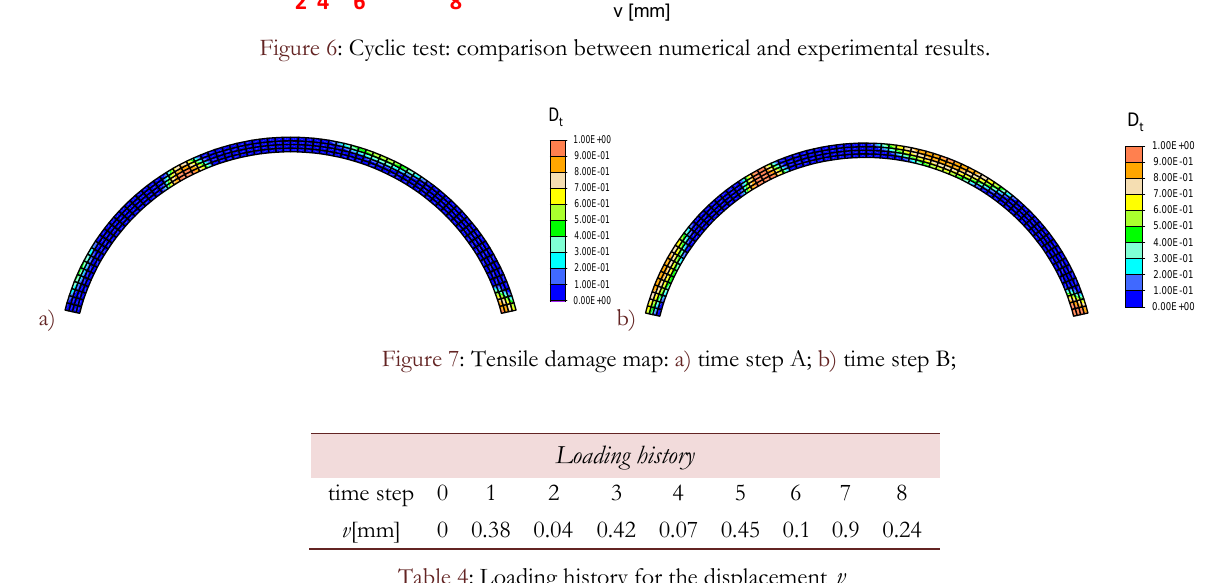
Table 4: Loading history for the displacement